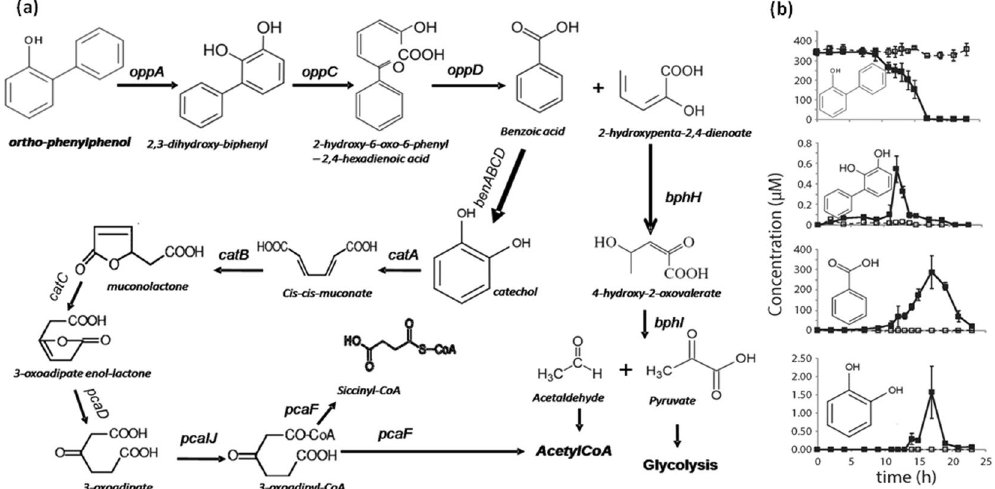
Figure 2. ( a ) The proposed metabolic pathway of ortho -phenylphenol (OPP) depicted by the genomic analysis of the Sphingomonas haloaromaticamans strain P3; ( b ) the degradation of OPP by strain P3, and the formation of 2,3-dihydroxybiphenyl, benzoic acid (BA) and catechol in inoculated ( ■ ) and non-inoculated samples ( □ ). Each value is the mean of three replicates ± the standard